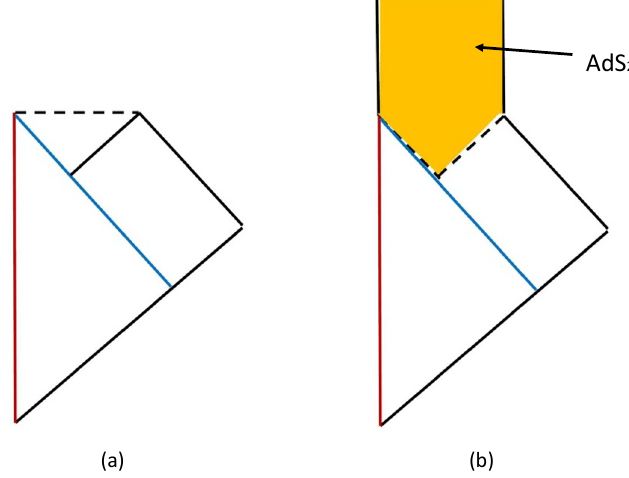
Figure 2 . The Penrose diagram of a black hole formed by a null wave. (a) The standard picture: the blue line represents the null wave, the dashed line is the black-hole singularity and the red line is the strong string-coupling region. (b) The IFS picture: the region behind the horizon is (cid:12)lled with IFS’s; asymptotically, it becomes AdS 2 space-time, and the horizon becomes singular in a way that prevents matter from falling into the AdS 2